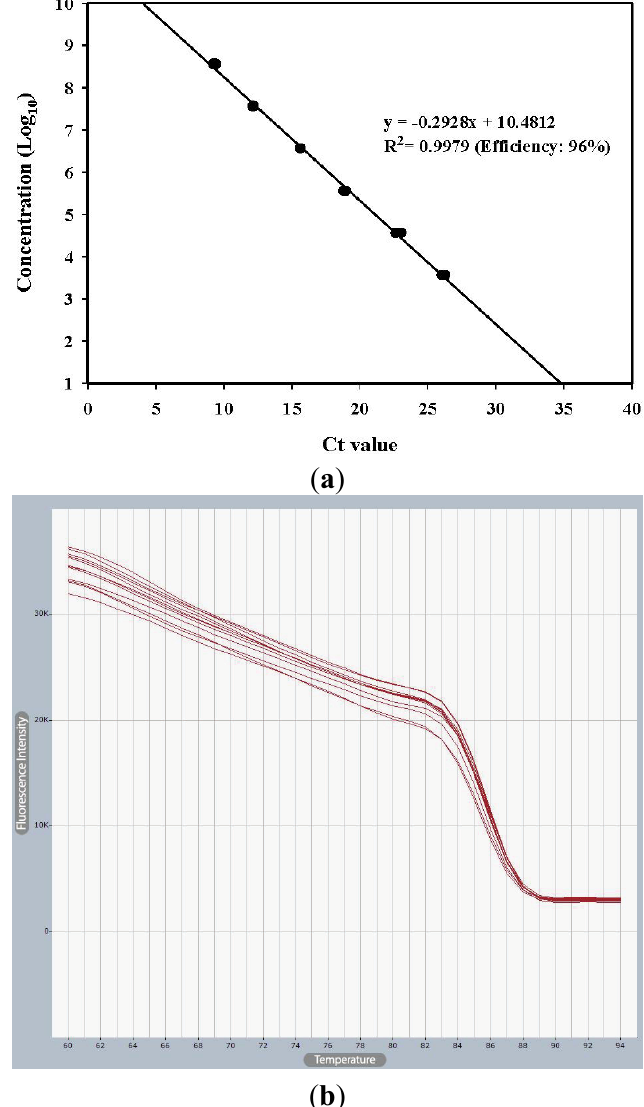
Figure 1. qRT-PCR standard curve ( a ) and melting curve ( b ). The plasmid DNA harboring viral hemorrhagic septicemia virus (VHSV) N gene was diluted by 10-fold and amplified in duplicate by quantitative PCR reaction. Standard curve for this N gene primers; slope = − 0.2928, R 2 =